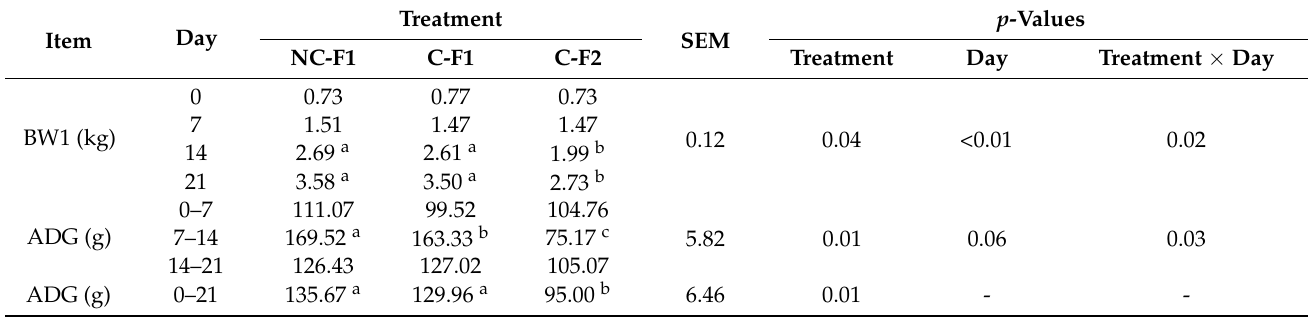
Table 2. Effect of different cross-fostering times on the growth performance of piglets.